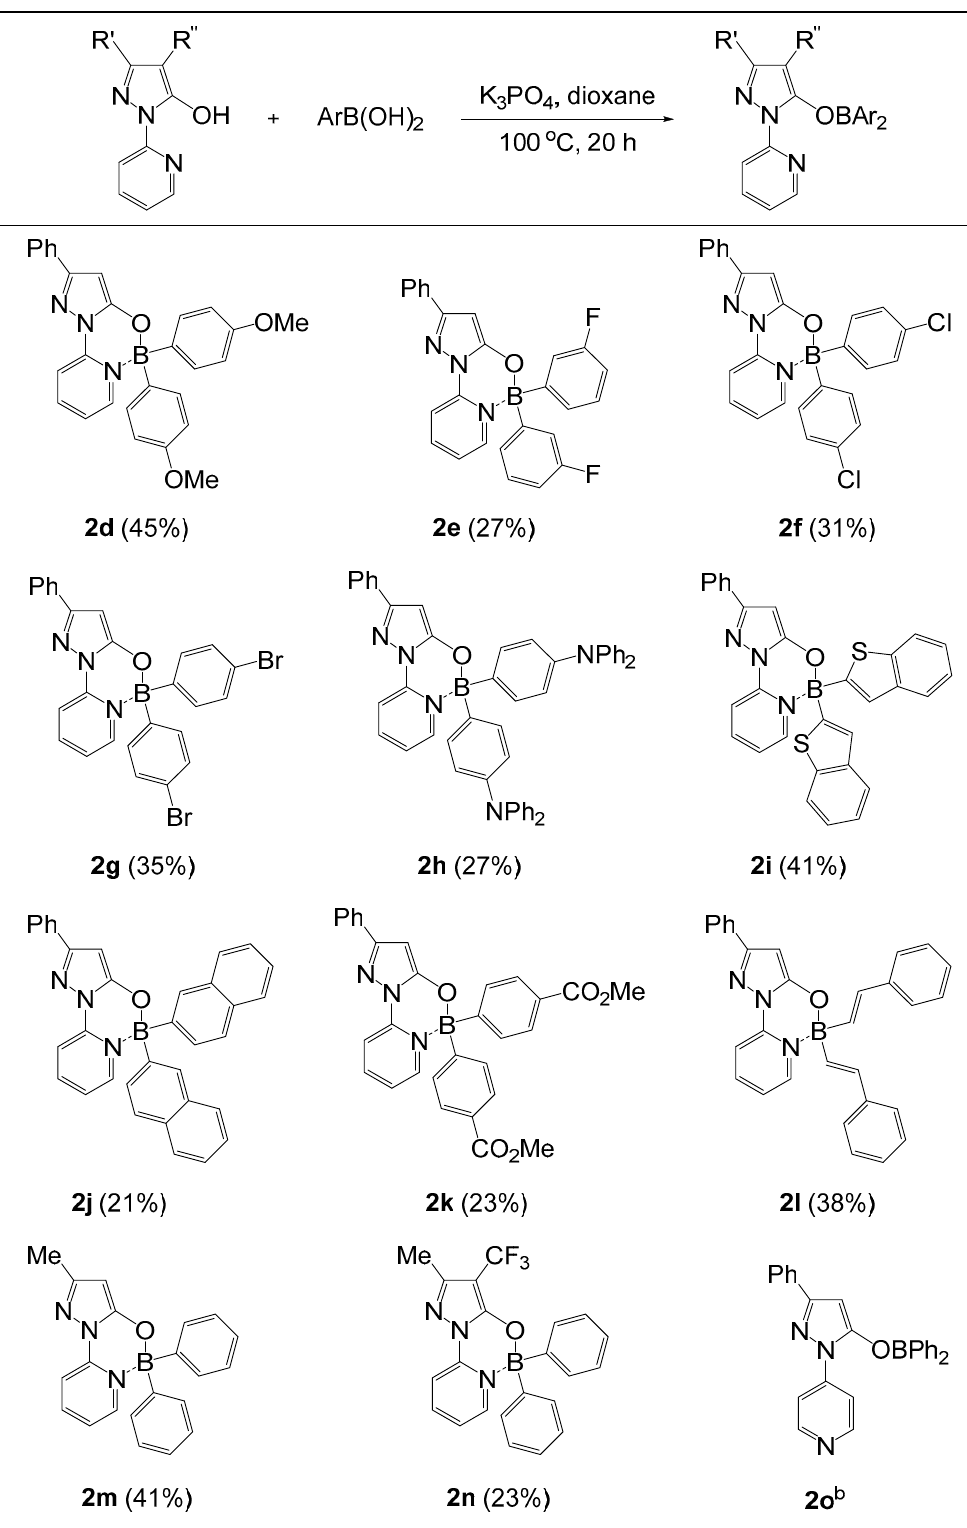
Table 2. Scope of boronic acids and pyrazole substrates a .